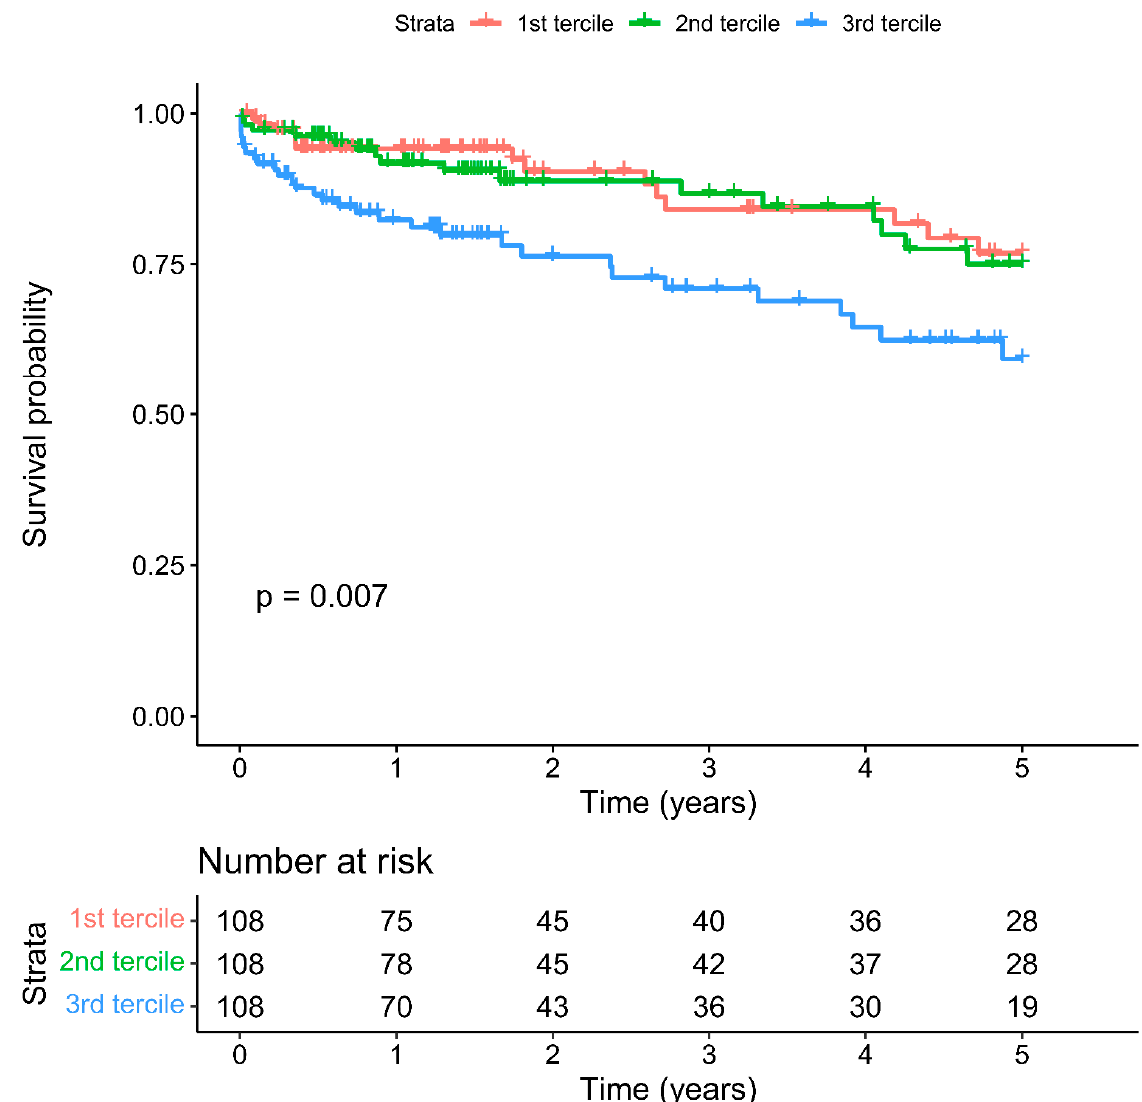
Figure 3. Cumulative five-year mortality in NLR